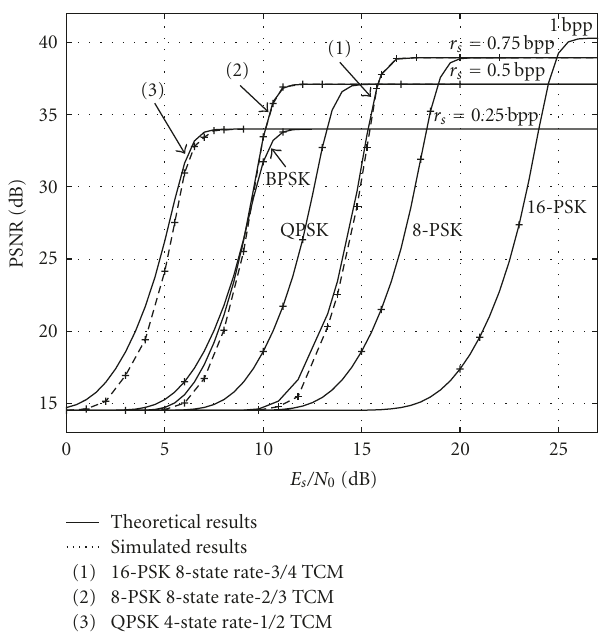
Figure 3: PSNR versus E s /N 0 performance of using a TCM system 512 Lena image us- for transmitting the SPIHT compressed 512 (cid:0) ing 65,536 symbols. The source coding rate for QPSK 4-state rate- 1/2 TCM, 8-PSK 8-state rate-2/3 TCM, and 16-PSK 8-state rate-3/4 TCM is 0.25, 0.5, and 0.75 bpp, respectively. Both theoretical curve based on (11) and respective simulation results are provided. The performance of uncoded systems of Figure 2 is also included for comparison purposes.